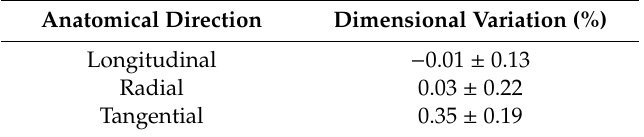
Table 4. Dimensional variation of wood samples after impregnation with